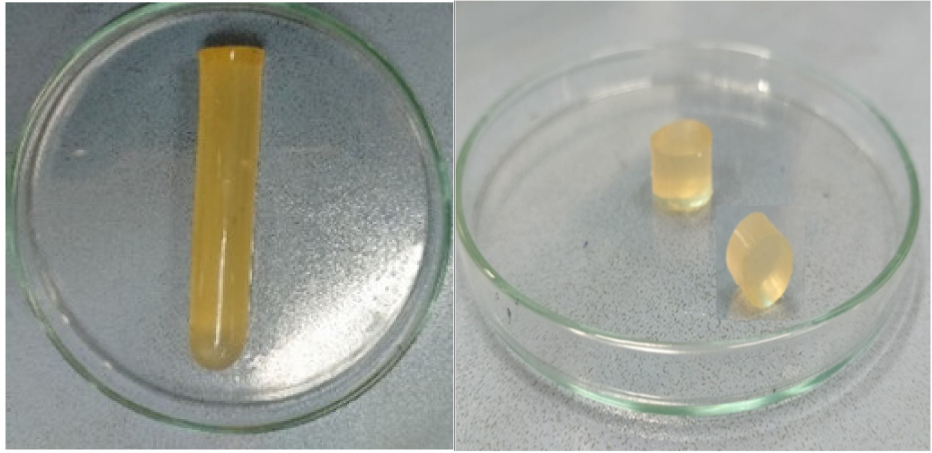
Figure 1. Physical appearance of